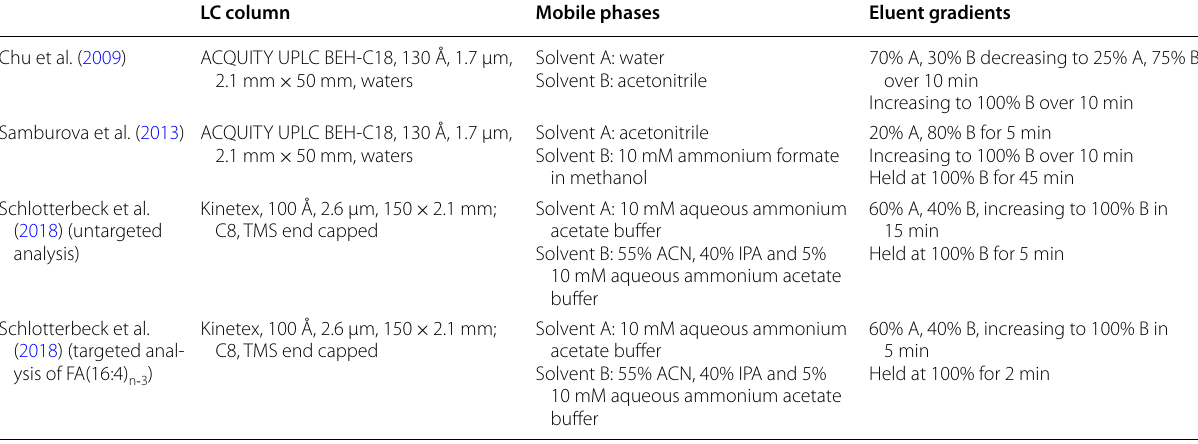
FA(16:4) n : hexadeca ‐ 4Z,7Z,10Z,13Z ‐ tetraenoic ‐ 3